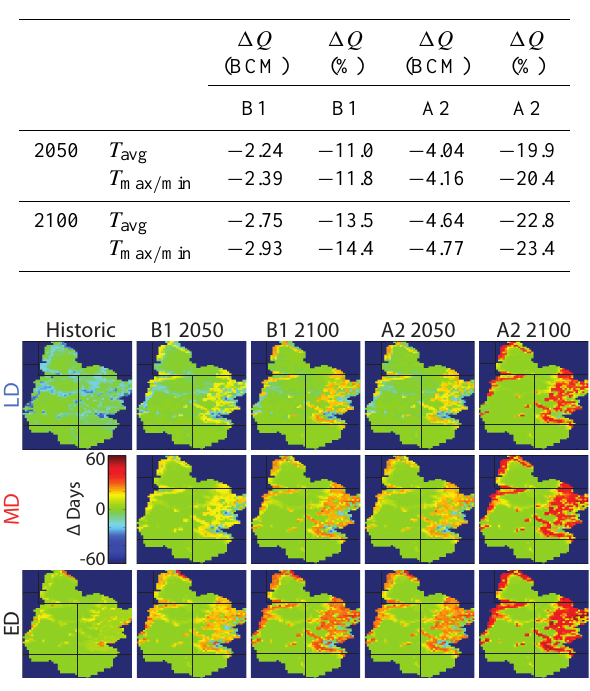
Table 4. Comparison of change in average annual runoff for 2050 and 2100 under B1 and A2 scenarios modeled by perturbing T max and T min both separately and equally ( T avg ) .